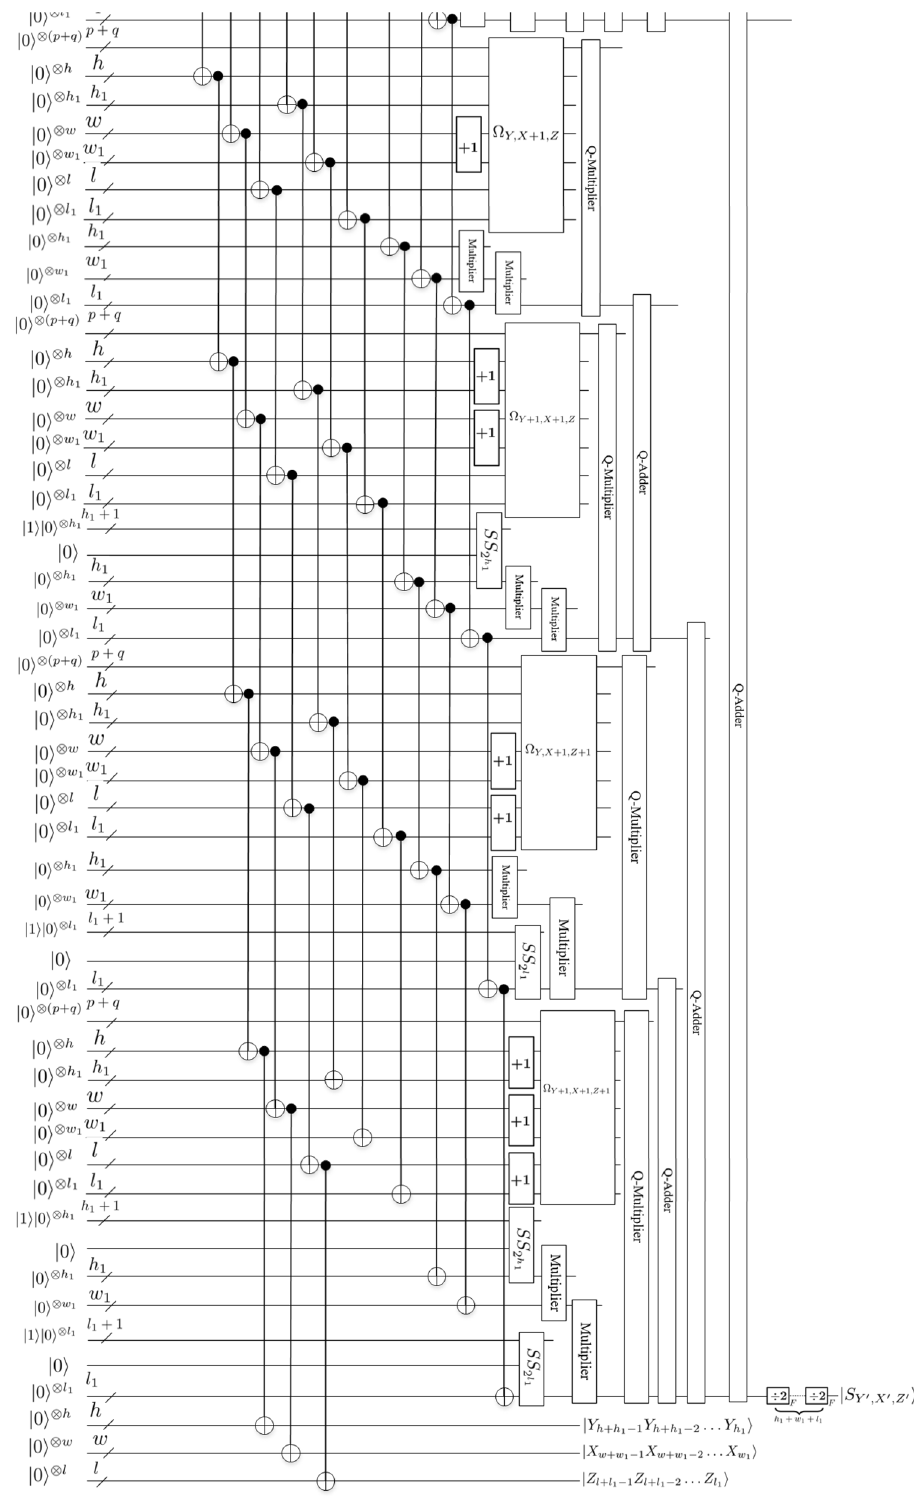
Figure 20. Scaling-down